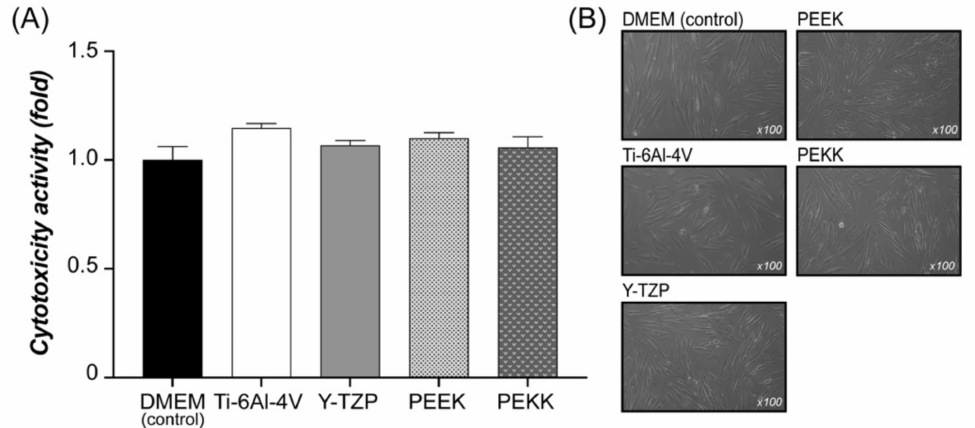
Figure 4. ( A ) Assessment of cytotoxicity activity by indirect exposure of HOF to extracts of the abut- ment materials (Ti-6Al-4V, Y-TZP, PEEK, and PEKK) through MTT assay. ( B ) The optical microscope image of HOF morphology in the extract of the abutment materials (original magnification ×